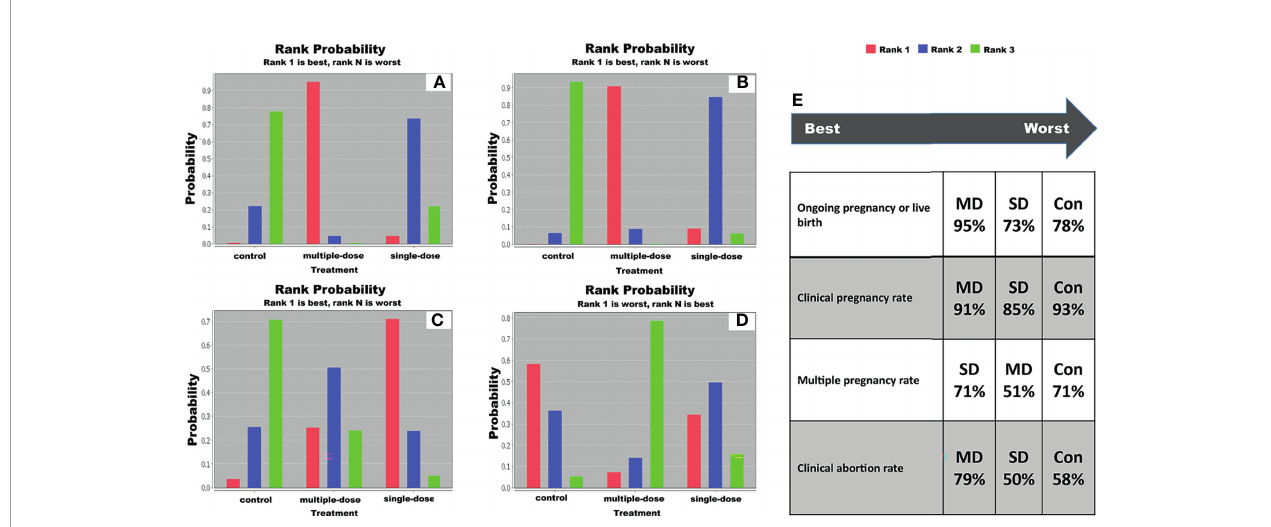
FIGURE 3 | Ranking probability diagram. (A) live birth rate, (B) clinical pregnancy rate, (C) multiple pregnancy rate, (D) clinical abortion rate, and (E) speci fi c ranking of each protocol in terms of individual outcome. SD, single-dose; MD, multiple-dose; Con,